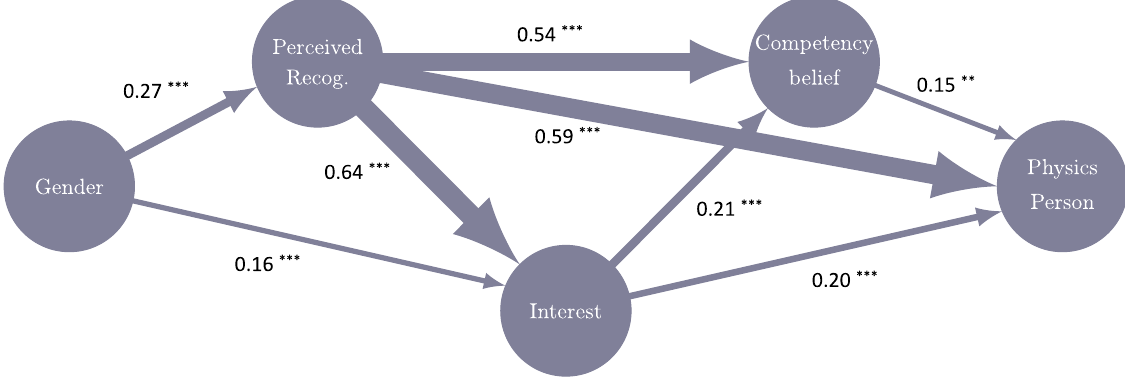
FIG. 2. Results of the structural equation modeling between gender and being a physics person through competency beliefs, interest, and perceived recognition. The line thickness corresponds to the magnitude of β values (standardized regression coefficients), p values < 0 . 001 are indicated by *** , and p values < 0 . 01 are indicated by **